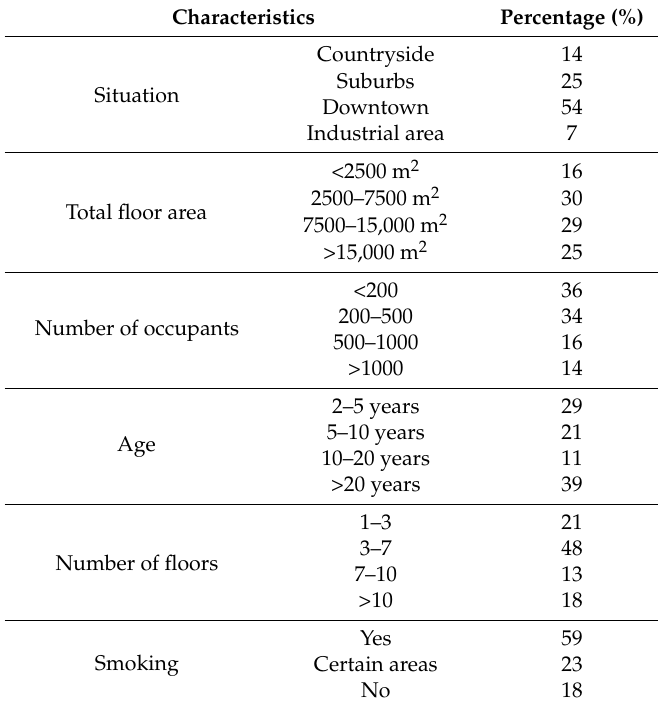
Table 2. Summary of the main characteristics of 56 selected buildings [18].